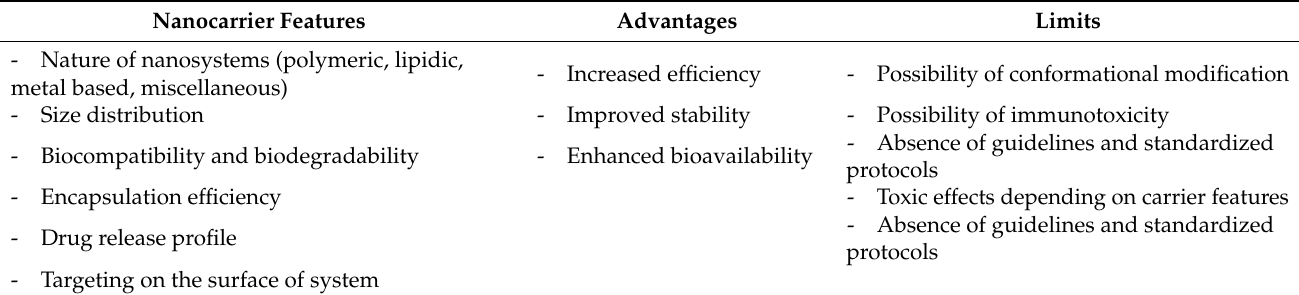
Table 1. Example of the most important parameters to be taken into account during formulation of nanonutraceuticals. The features of nanocarriers influencing the efficacy of the delivered drugs are mentioned. Nanocarrier